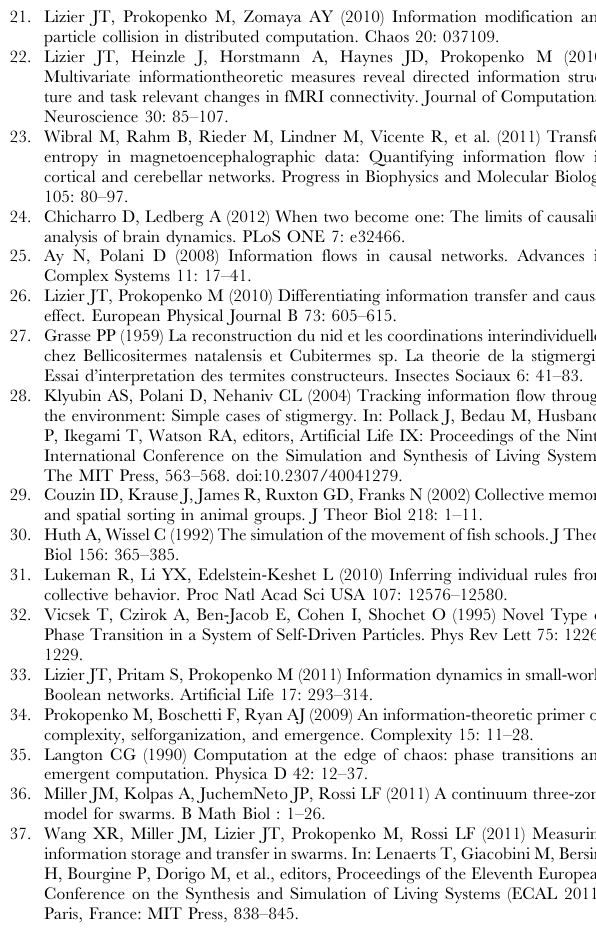
highlighting the specified time. The bottom panel shows the swarm dynamics at the specified time, the individuals’ two- dimensional positions are plotted on the x and y axes. The local TE values for each individual is shown here in different colours, according to the scale on the right. Note the colours are scaled differently for positive and negative values. (MOV) Movie S3 Local active information storage (AIS) of swarm individuals over time for experiment 2. We start the simulation with the swarm individuals in three squares of checker configuration; each square is 28 | 28 in size. The top panel shows the overall AIS as depicted in Figure 2 in the main text, with the vertical line highlighting the specified time. The bottom panel shows the swarm dynamics at the specified time, the individuals’ two-dimensional positions are plotted on the x and y axes, with the colours of each individual denoting the value of its local AIS. The local AIS values for each individual is shown here in different colours, according to the scale on the right. Note the colours are scaled differently for positive and negative values. (MOV) Movie S4 Local transfer entropy (TE) of swarm indi- viduals over time for experiment 2. We start the simulation with the swarm individuals in three squares of checker